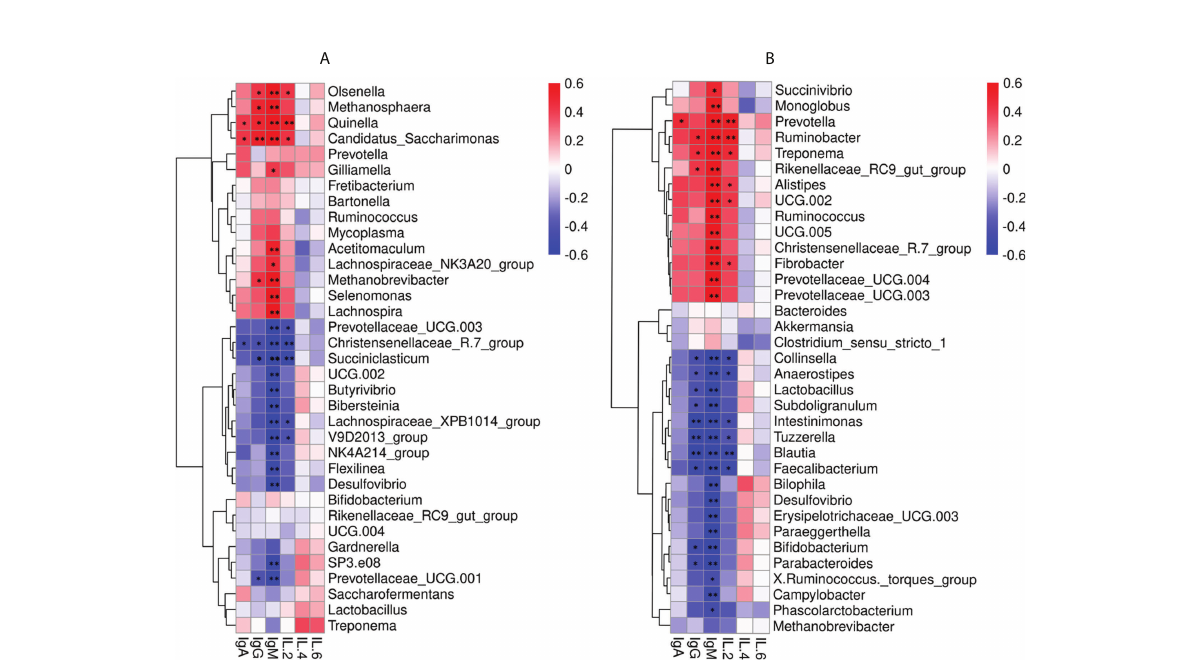
FIGURE 5 Correlation between the immune factors and the rumen and fecal bacteria at the genus level. (A) Spearman correlation between rumen samples (MR, IR) and serum immune factors. (B) Spearman correlation between fecal samples (MC, IC) and serum immune factors. * P < 0.05, ** P <